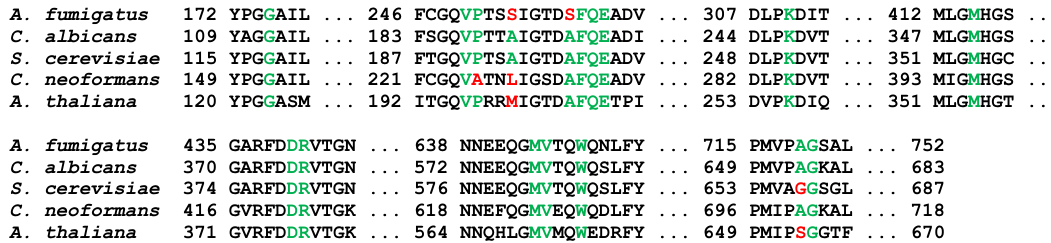
Figure 4. Partial alignment of four fungal and one plant AHAS sequences highlighting the herbicide binding site residues. The conserved residues are in green, while the variants are in